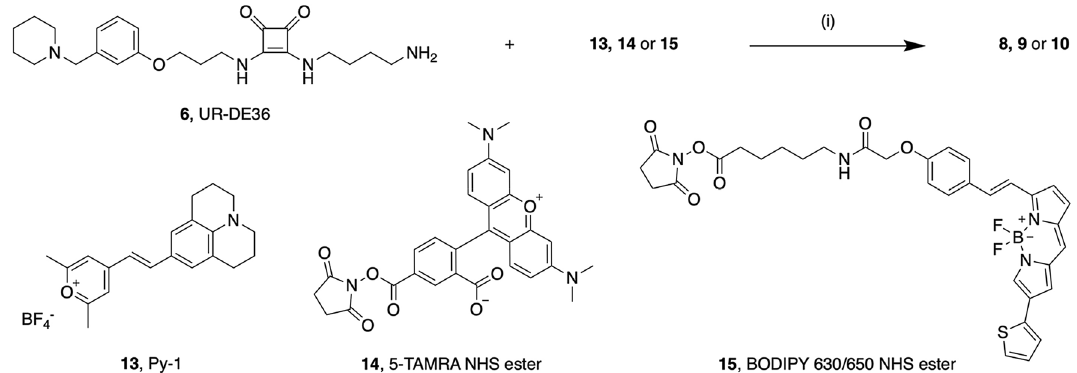
Figure 2. Synthesis of fluorescent ligands 8 – 10 . Reagents and conditions: (i) 6 (1.5 equiv.), NEt 3 (7.5 or 11 equiv.), 13 , 14 or 15 (1 equiv.), DMF, rt, 2